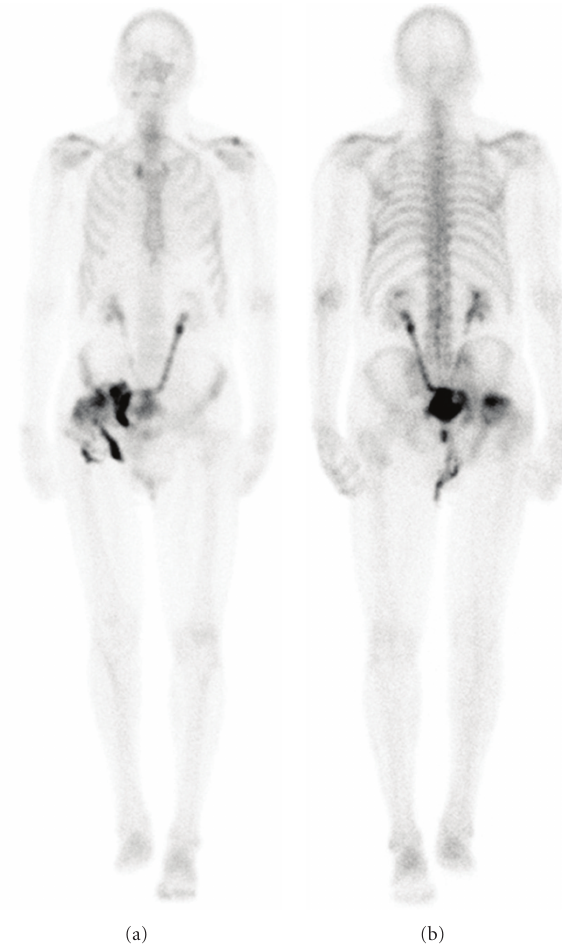
Figure 1: Nuclear medicine bone scan demonstrating an ileal conduit leak into the deep pelvis. No metastatic disease detected (anterior view on the left and posterior view on the right).